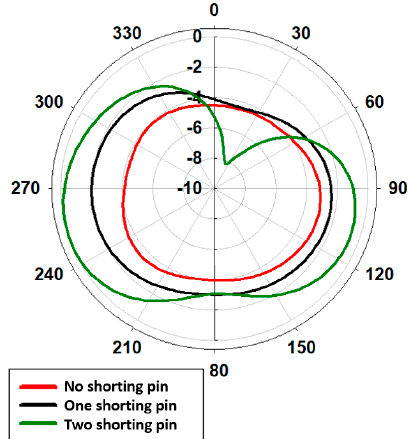
Figure 7. Effect of shorting pins on the 2D antenna radiation pattern.